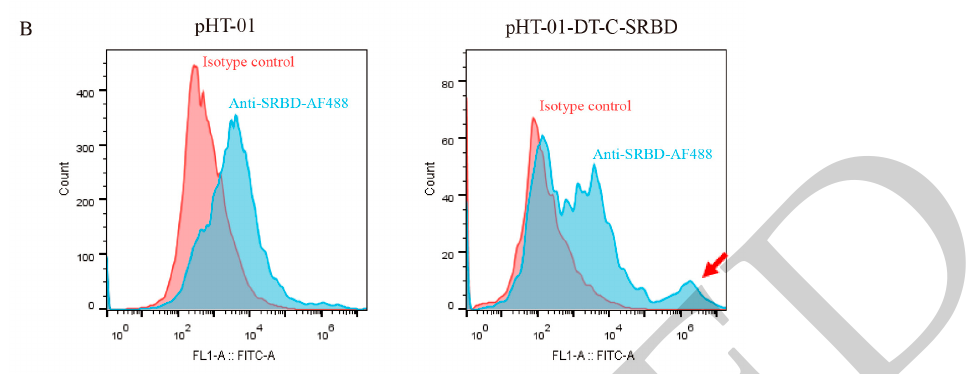
Figure 2. ( A ) Immunofluorescent staining of sRBD protein on recombinant B. subtilis spores visualized under the fluorescent microscope. Three sRBD expression constructs linked with different coating proteins, CotA, CotB and CotC, were cloned and transformed into B. subtilis WB800N strain for protein expression. Only the CotC-linked sRBD protein was able to display sRBD on the surface of recombinant B. subtilis spores. ( B ) Flow cytometry of recombinant B. subtilis spores transformed with empty vector pHT-01 and CotC-linked sRBD expression construct. The CotC-linked sRBD expressed B. subtilis spores were immunoreactive to anti-sRBD (indicated by a red